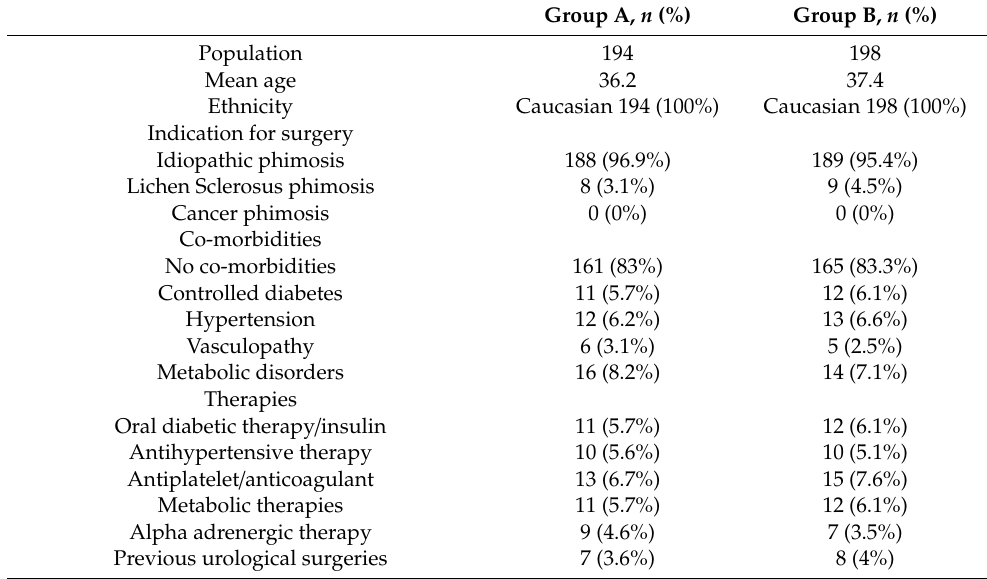
Table 1. Demographics characteristics of group A and B.